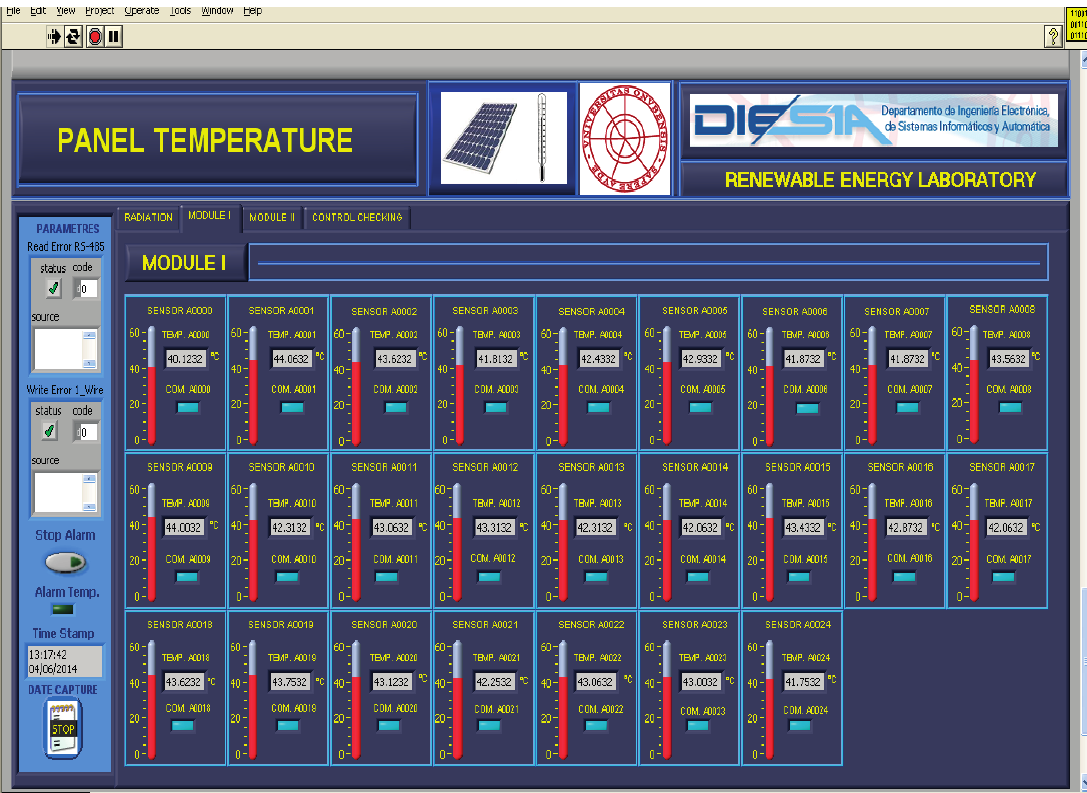
Figure 9. Virtual instrument (VI) for monitoring the temperature of each panel at the